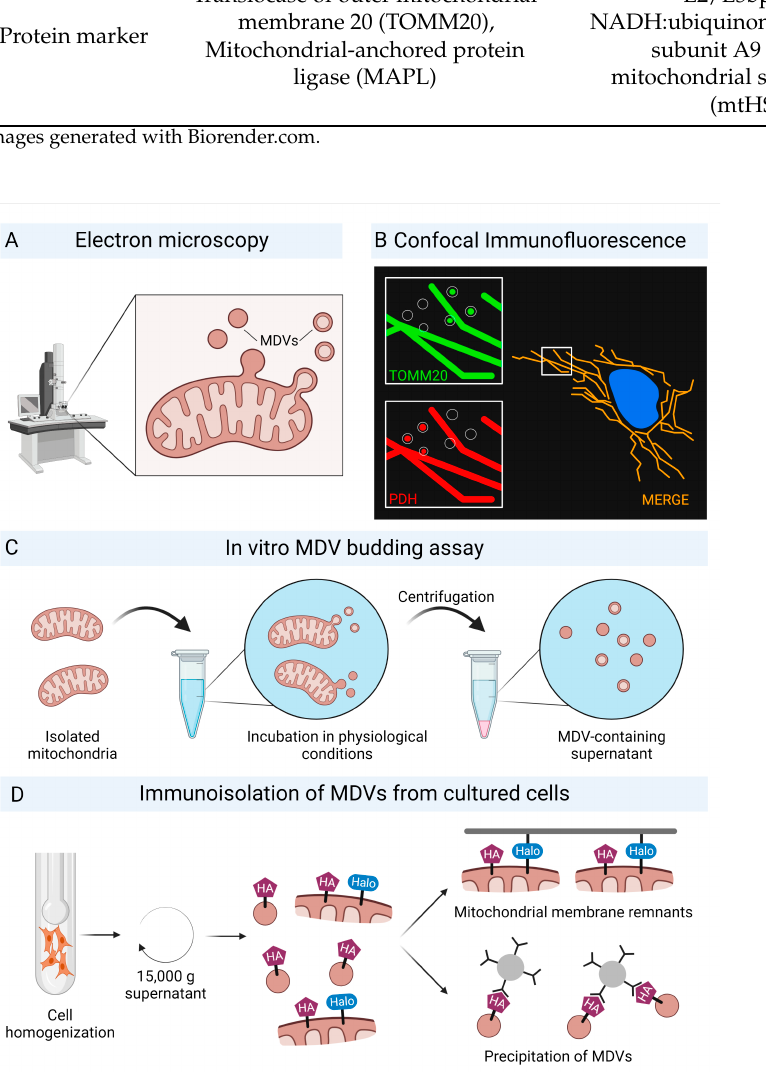
Figure 1. Characterization of mitochondrial-derived vesicles (MDVs). ( A ) Visualization of MDVs by electron microscopy. MDVs with a single membrane form from the outer mitochondrial membrane, whereas MDVs with two membranes form from the inner and outer mitochondrial membranes. ( B ) TOMM20, an outer mitochondrial membrane protein, and PDH, located at the mitochondrial ma- trix, are two MDV marker proteins for immunofluorescence labeling of MDVs. MDVs are TOMM20 or PDH-positive. White square indicates the merge. ( C ) In vitro MDV budding assay in physiologi- cal buffer conditions using isolated mitochondria. ( D ) Immunoisolation of MDVs from cultured cells using hemagglutinin (HA)- and halo-tagging. Created with